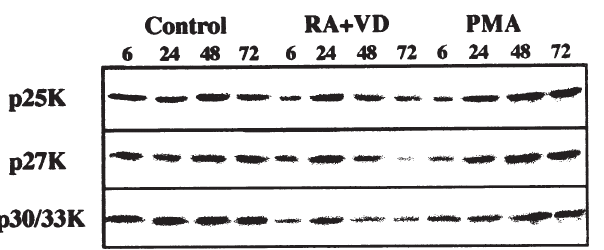
Fig. 4. Western blot detection of proteasomal protein subunits in whole cell extracts during the 72 h period of differentiation induced by RA+VD or